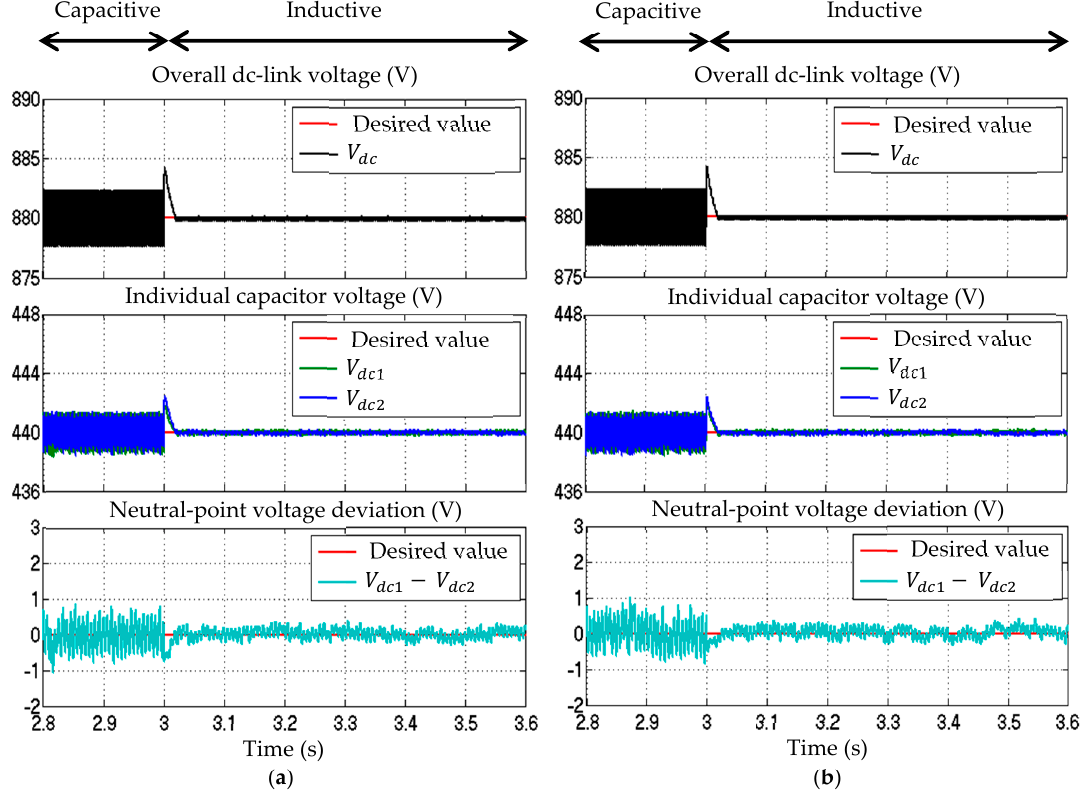
Figure 8. Simulation result showing the overall dc-link voltage V dc , individual capacitor voltages V dc 1 and V dc 2 , and neutral-point voltage deviation ( V dc 1 − V dc 2 ) , demonstrated by SAPF while applying: ( a ) the proposed algorithm; and ( b ) the existing algorithm, for dynamic-state condition of capacitive to inductive loads.